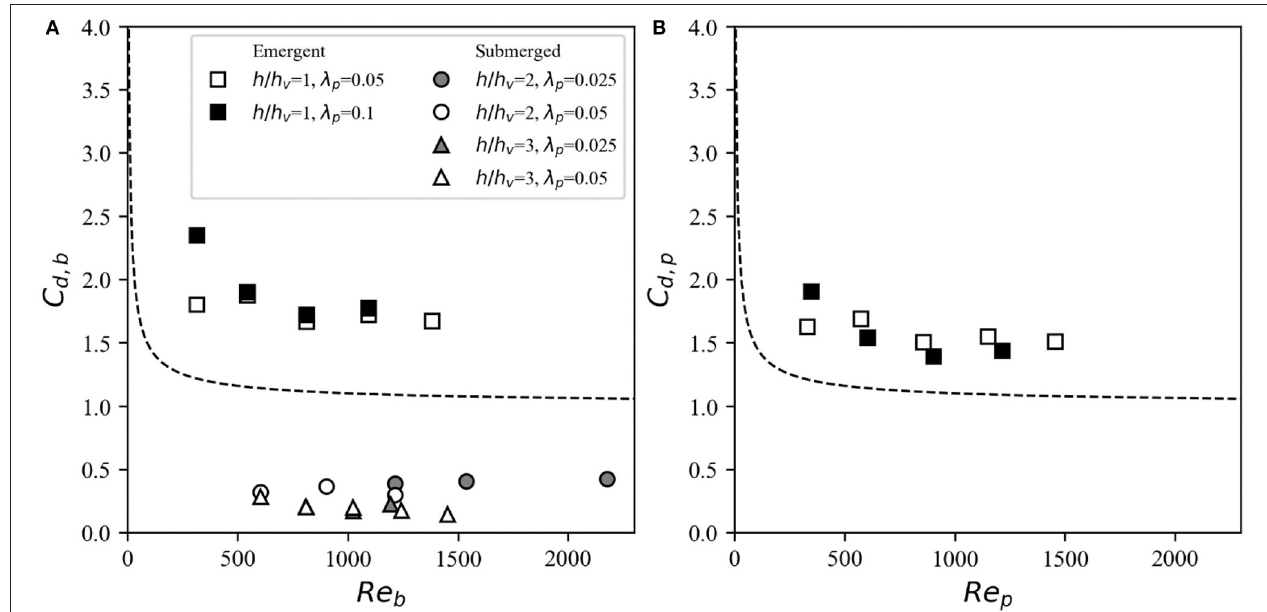
FIGURE 6 | Drag coefficients derived from the drag force measurements using (A) the bulk velocities U em b and U sub b and (B) the pore velocity U em p as the reference velocity for the emergent (squares) and submerged (circles: h / h v white: λ p 0.05; gray: λ p 0.025), with theoretical values for an isolated cylinder (Equation 2) denoted by the dashed line. = =